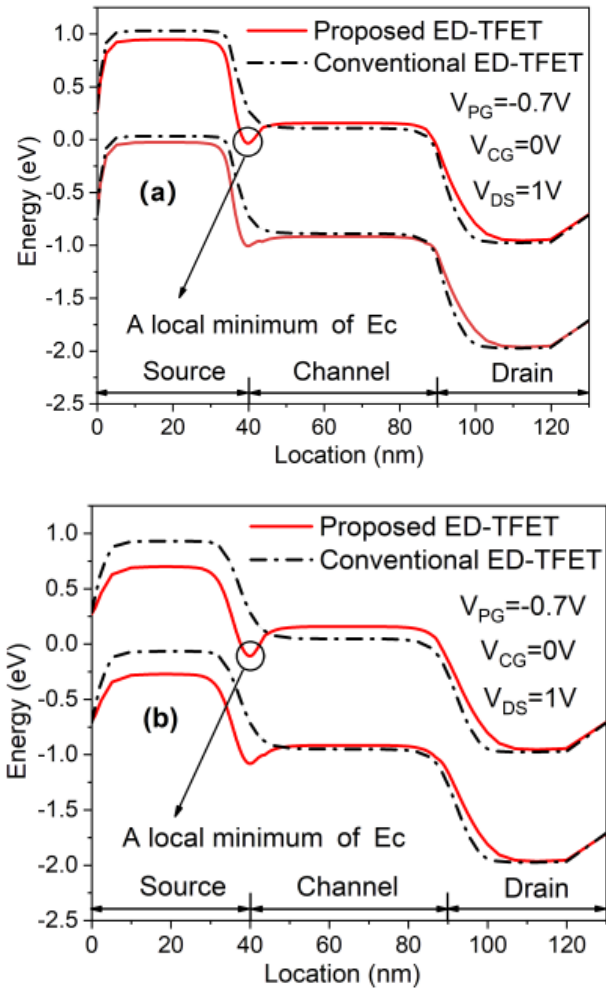
Figure 2. Energy band diagrams at ( a ) 1 nm and ( b ) 5 nm below the Si-oxide interface of the conventional and proposed ED-TFET at OFF -state.